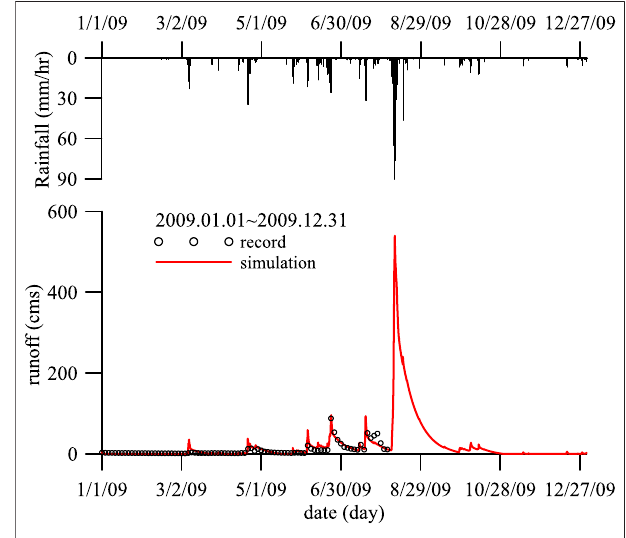
FIGURE 7 | Calibrated river runoff volume fl ow rate of the TienChih catchment for 2009. The volume fl ow rate data were recorded by the A-Chyi- Ba Bridge station of the Laonung River. The measurement stopped on 8/9 because the instruments were destroyed by fl ooding.